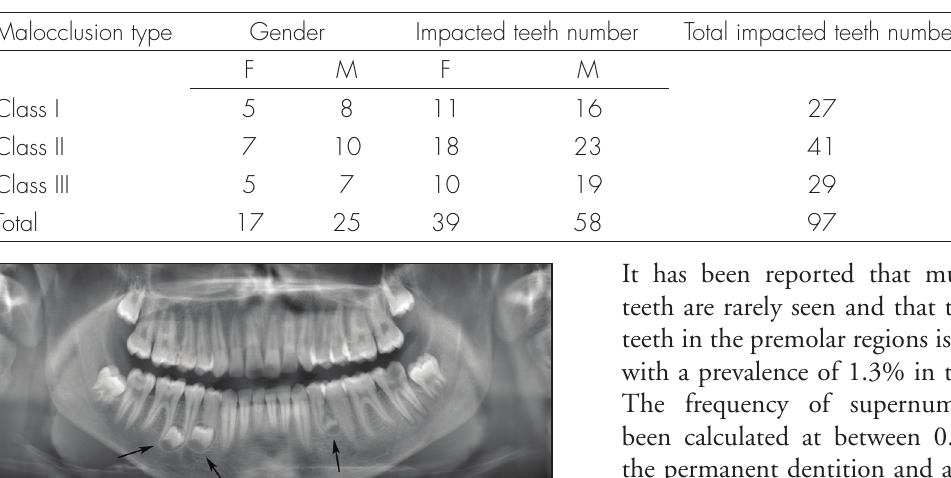
Table II. The distribution of number of patients and number of supernumerary premolars according to gender and malocclusion